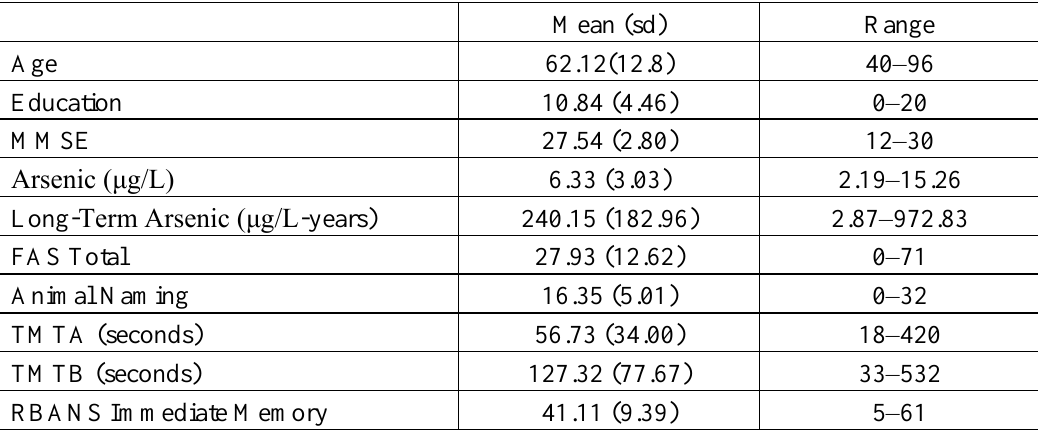
Table 2. Demographic